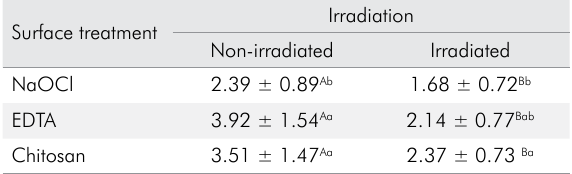
*Different upper-case letters indicate statistical difference on the lines and different lower-case letters indicate statistical difference in the columns (Tukey’s p <